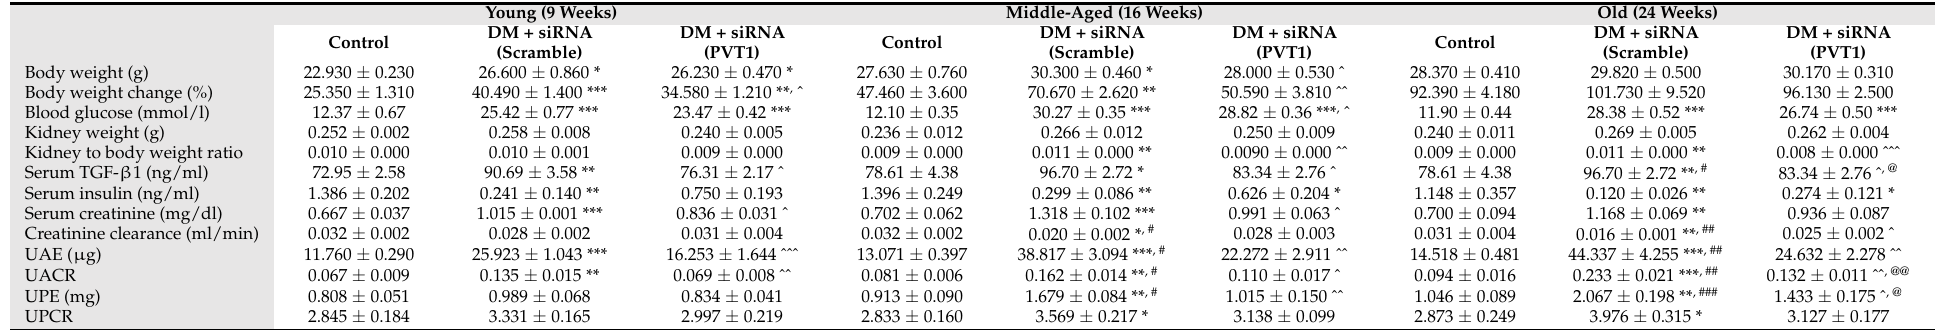
Table 2. Physical and biochemical characteristics of siRNA-treated diabetic and control mice of different age groups. Diabetic mice were treated with either scramble-siRNA (DM + siRNA (scramble)) or PVT1-siRNA (DM + siRNA (PVT1)), whereas control mice were normal mice without siRNA injection (Control). Data were presented as means ± SEM, n = 6. A p -value < 0.05 was considered statistically significant using one-way ANOVA with Tukey post-test (* p < 0.05, ** p < 0.01, *** p < 0.001 vs. age-matched control; ˆ p < 0.05, ˆˆ p < 0.01, ˆˆˆ p < 0.001 vs. age-matched DM + siRNA (scramble); # p < 0.05, ## p < 0.01, ### p < 0.001 vs.